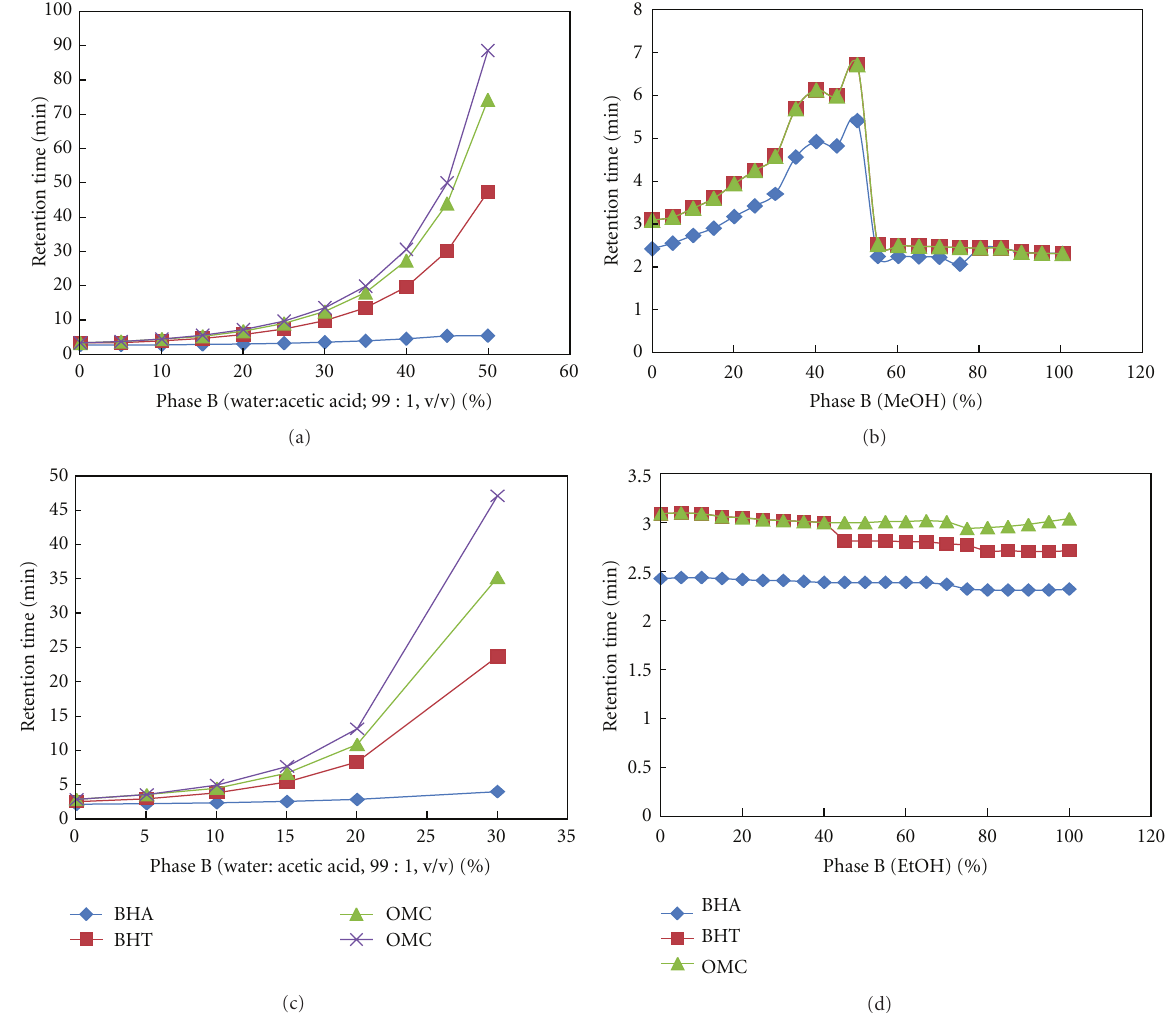
Figure 4: E ff ect of mobile phase composition on retention time of BHA, BHT, and OMC.